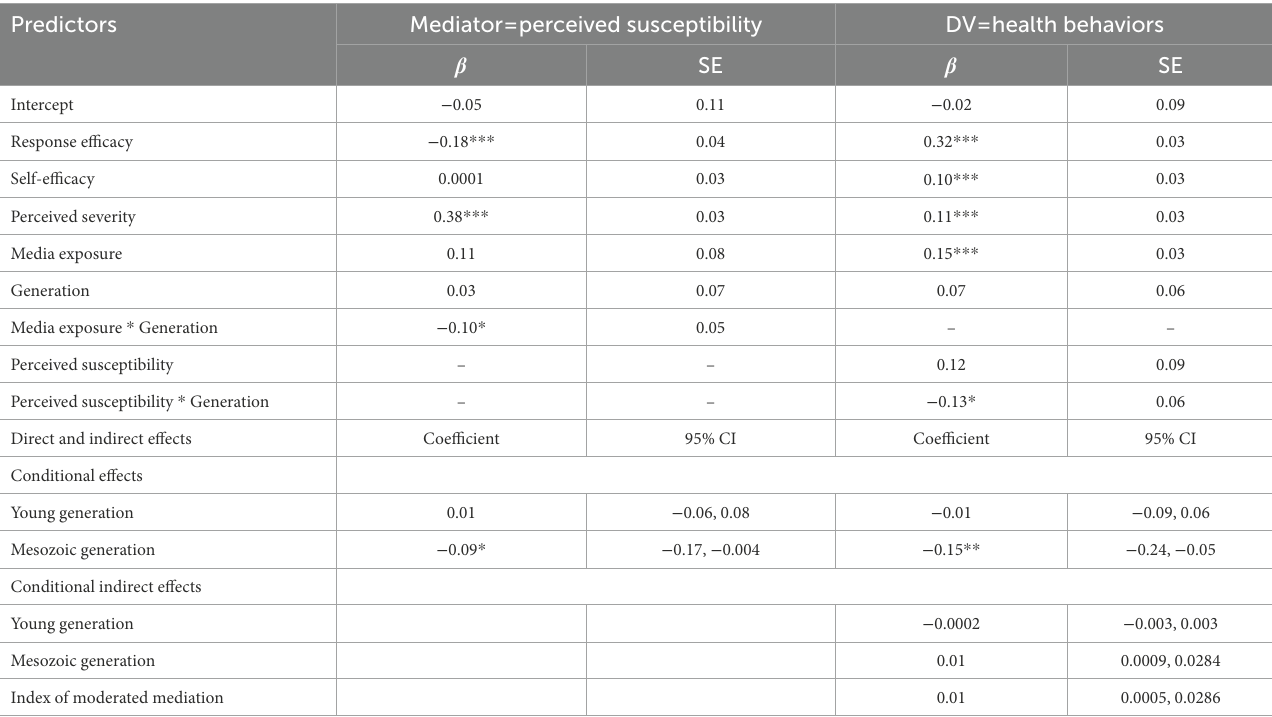
TABLE 7 Moderated mediation